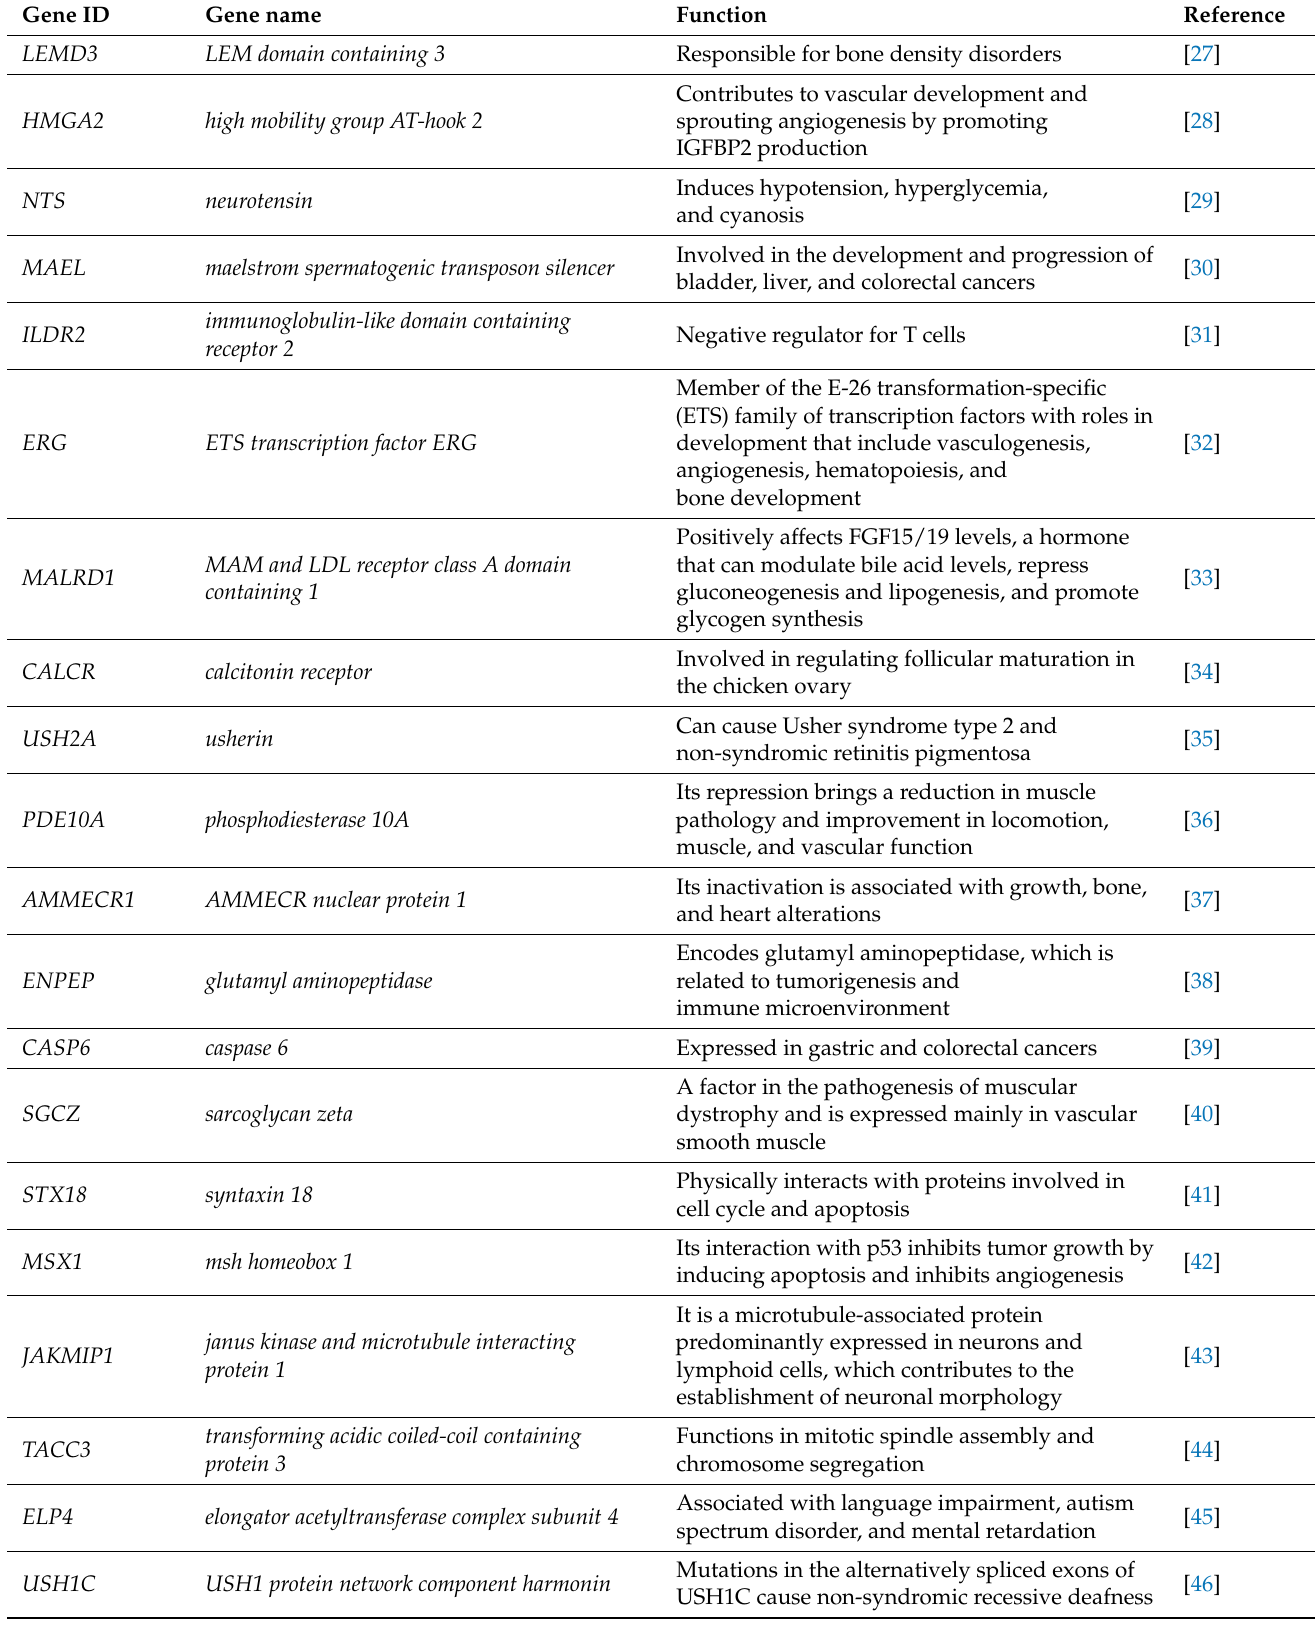
Table 2. Gene ID, name, function, and reference for genes annotated in the meta-analysis